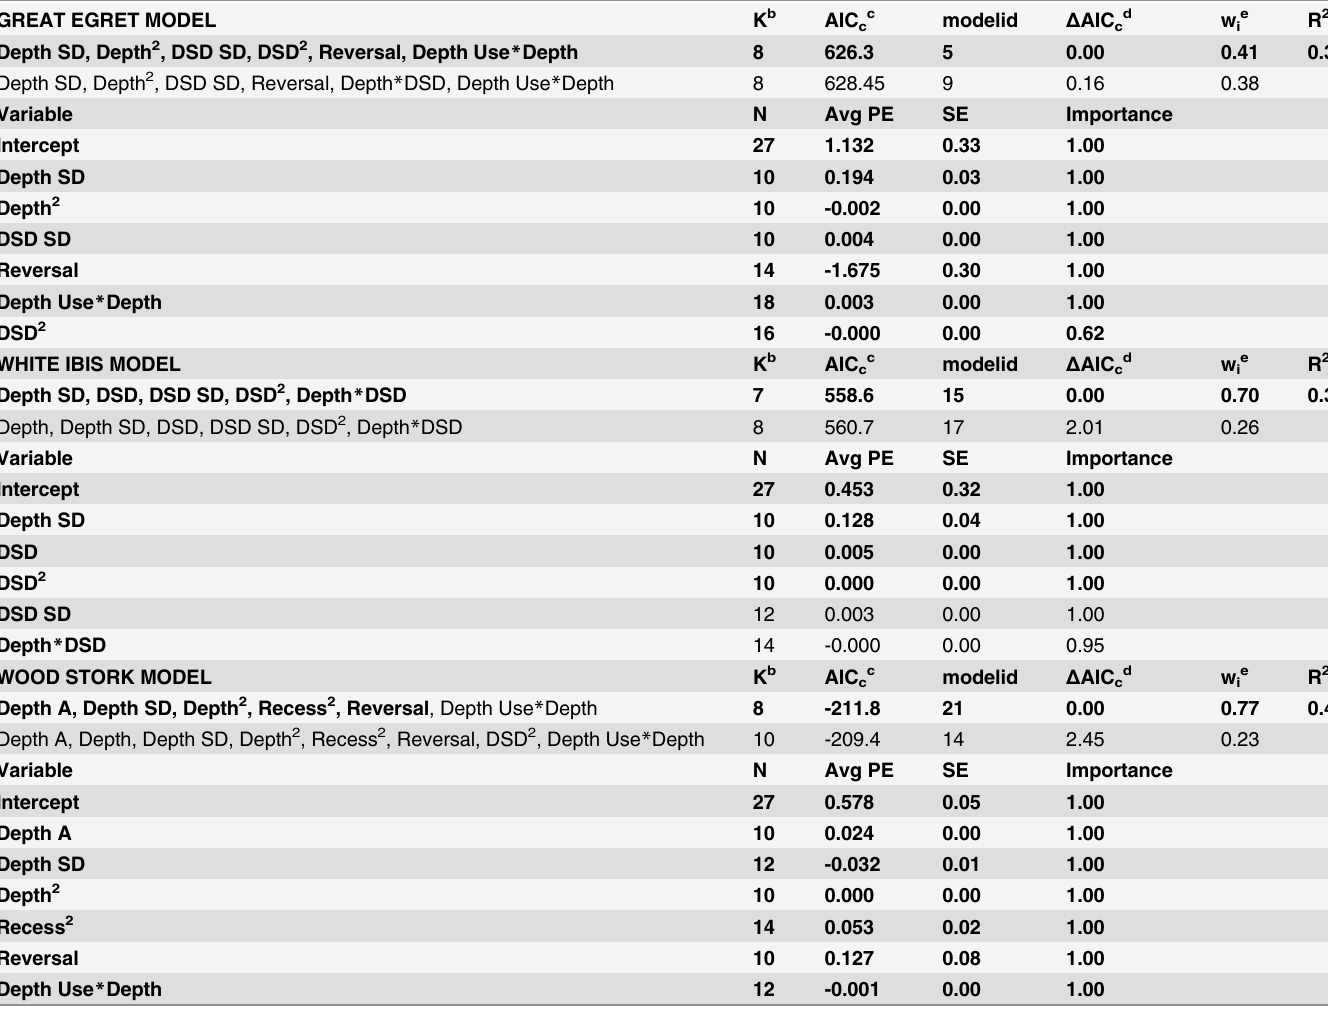
Models are ranked by differences in Akaike ’ s information criterion and only candidate models within Δ AIC cd (cid:3) 4.0 are presented. Model selection results are followed by model averaging results for each species. The R 2 represents the model fi t for the estimated daily fl ock abundance vs. model averaged predicted